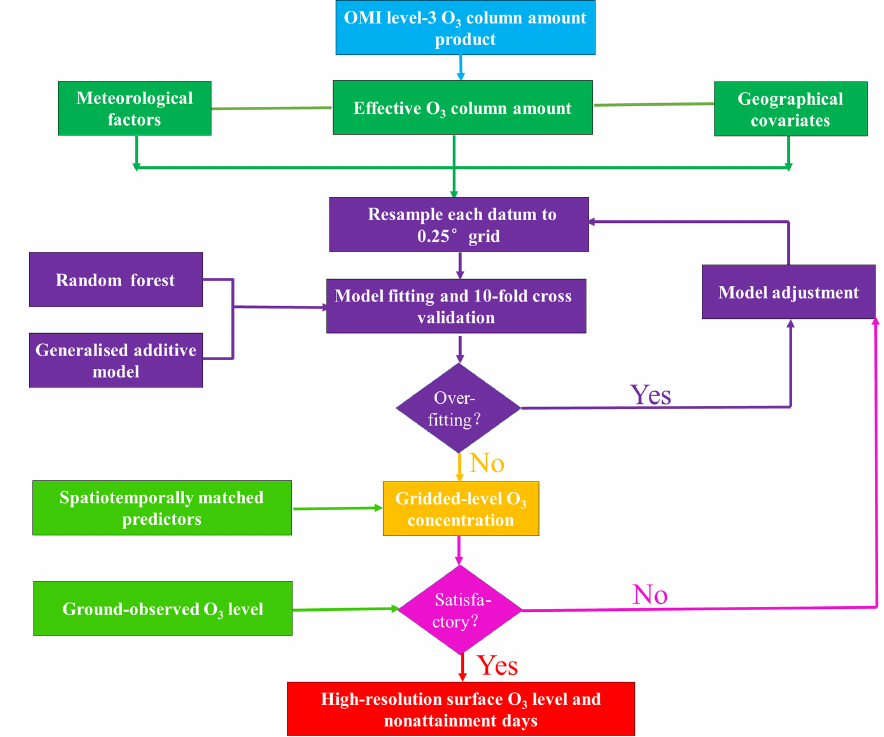
Figure 2. The workflow for predicting the spatiotemporal distributions of 8h O 3